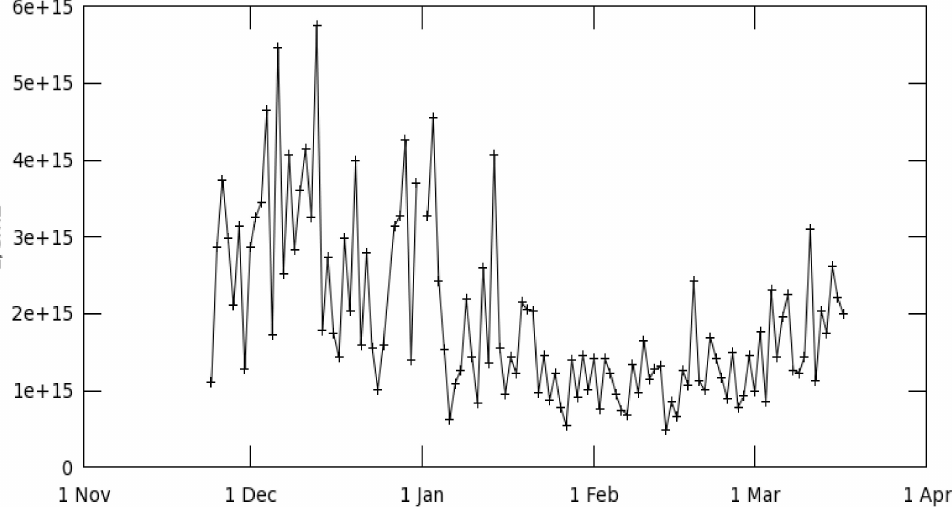
Figure 5. Time series, area-average of NO 2 tropospheric column (30% cloud screened) daily 0.25 deg. [OMI OMNO2d v003] 1/cm 2 over 24 November 2019–22 March 2020, shape China. Source: OMI, Global Modeling and Assimilation Office, NASA, 2020.